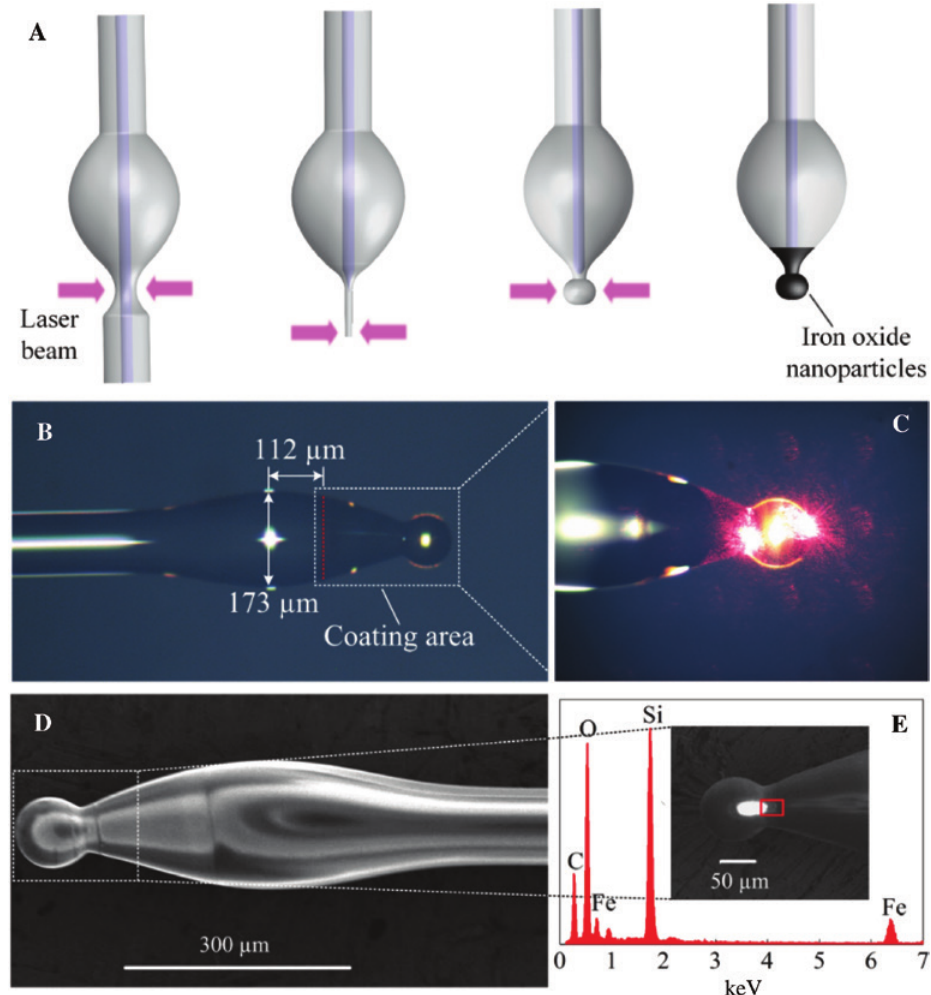
Figure 2: Fabrication process and characterization of the proposed silica microbottle cavity. (A) Fabrication process of the proposed silica microbottle cavity. (B) Optical micrograph of the higher- Q microbottle cavity with a short and spherical end. (C) Close-up view of the coating area. (D) SEM micrograph of the higher- Q microbottle cavity. (E) Measured energy dispersive X-ray (EDX) spectroscopy of the tapered area coated with iron oxide nanoparticles. Inset: close-up SEM micrograph of the coating